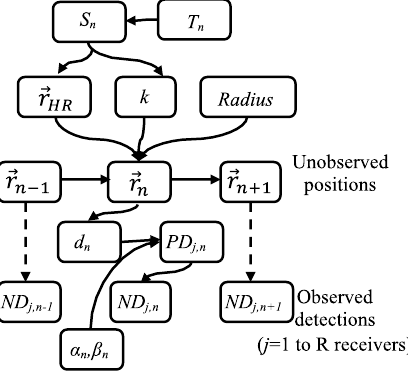
−→ r n at time step n Figure 1. Directed acyclic graph of the State-Space Model (SSM). The unobserved position is generated following a combination of movement parameters (the process model) of the fish: position of the −→ r HR ), strength of the driving force attracting the individual to the centre of the home centre of the home range ( range ( k) and Radius of the home range. The actual position ( n ) depends on the previous position ( n-1 ), and the behavioural state (Sn; swimming vs. hidden) at time step n and is determined by the transition matrix T n (Eq. 1, see main text). The observed data (number of detections, ND) at time n consists of all the detections recorded by each one of the receivers ( j in R). Note that ND at time n is independent of the ND at time n-1 and is generated using the probability of detection by receiver j at n time unit ( PD j,n ) determined by a logit function (with parameters α and β at time n ) of the distance ( d at n ) between the (unobserved) fish position and the (known) receiver position (observational model).